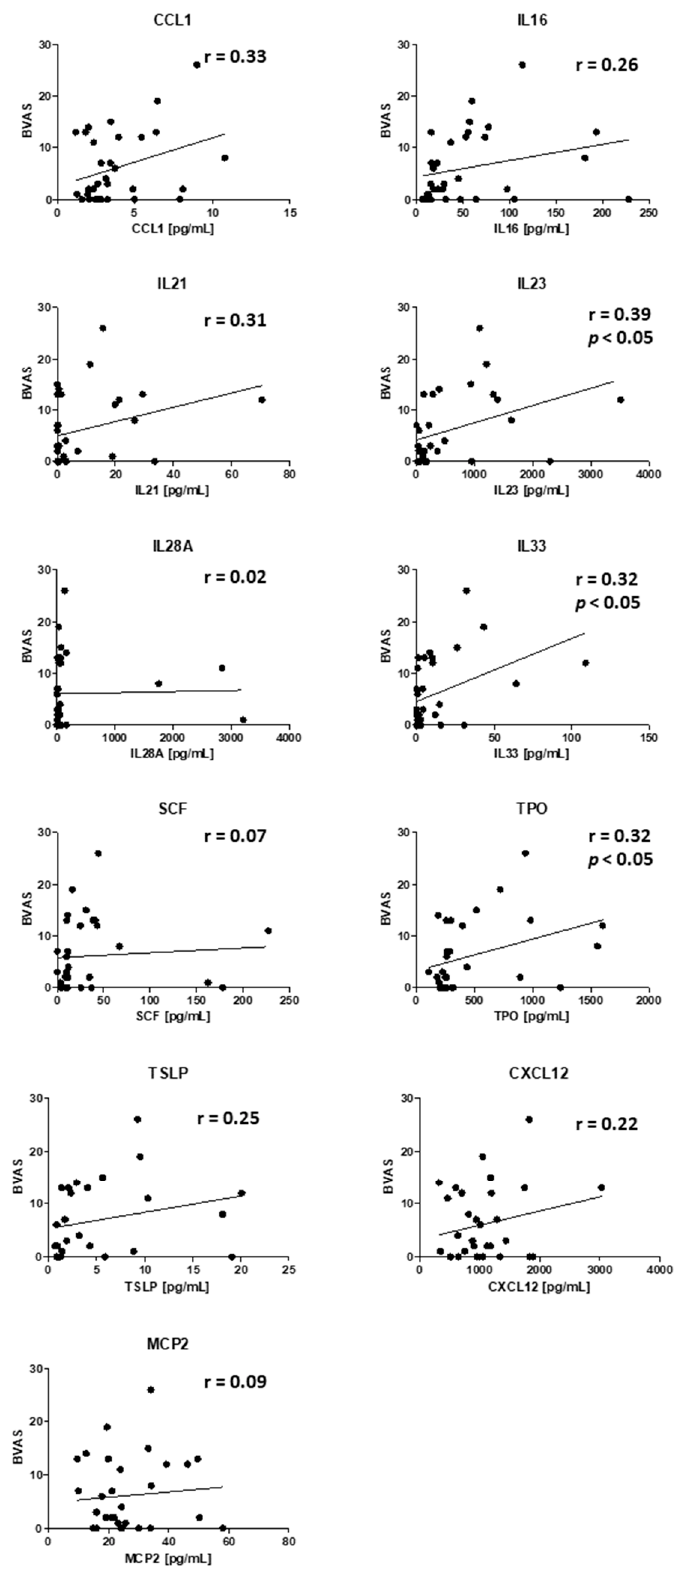
Figure 3. Correlation of BVAS and cytokines upregulated in active PR3-AAV. r = correlation coeffi- cient, p < 0.05 = significant correlation, n = 32 samples.